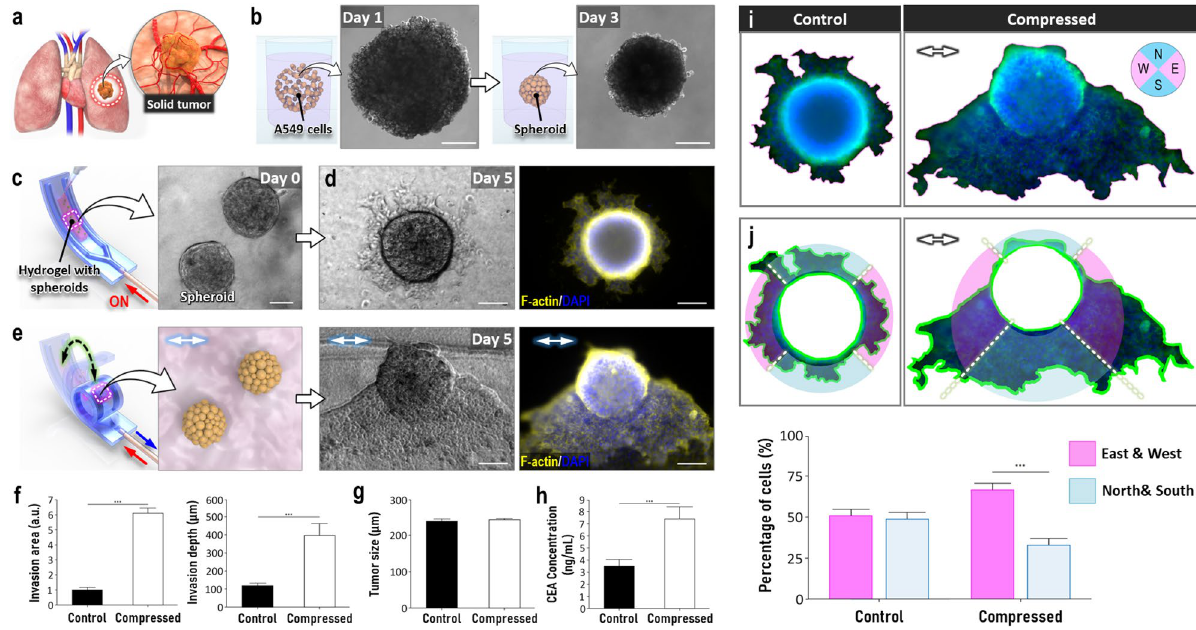
Figure 5. In vitro modeling of solid tumor in the soft robotic constrictor. ( a,b ) A549 spheroids formed in low-attachment wells are used to model malignant tumors in the lung. Scale bars, 100 µm. ( c ) Micrograph of tumor spheroids embedded in type I collagen hydrogel in the device. Scale bar, 100 µm. ( d ) Phase contrast (left) and fluorescence (right) images of lung tumor after 5 days of static culture. Scale bars, 50 µm. ( e ) Micrographs of dynamically compressed lung tumor at Day 5. Scale bars, 100 µm. ( f ) Quantification of invasion area and depth. ( g ) Comparison of tumor size in the presence or absence of compression. ( h ) ELISA-based quantification of CEA secreted by lung tumors. ( i ) Delineation of the outline of tumor and invading cancer cells using fluorescence micrographs shown in ( d,e ) E, W, S, and N in the circular direction map represent east, west, south, and north, respectively. ( j ) Radial segmentation of tumor regions and quantification of directional cancer cell migration. Arrows in this figure show the direction of applied compressive force. ***P < 0.001, **P < 0.01, *P < 0.05. Data show mean ± SD with n =